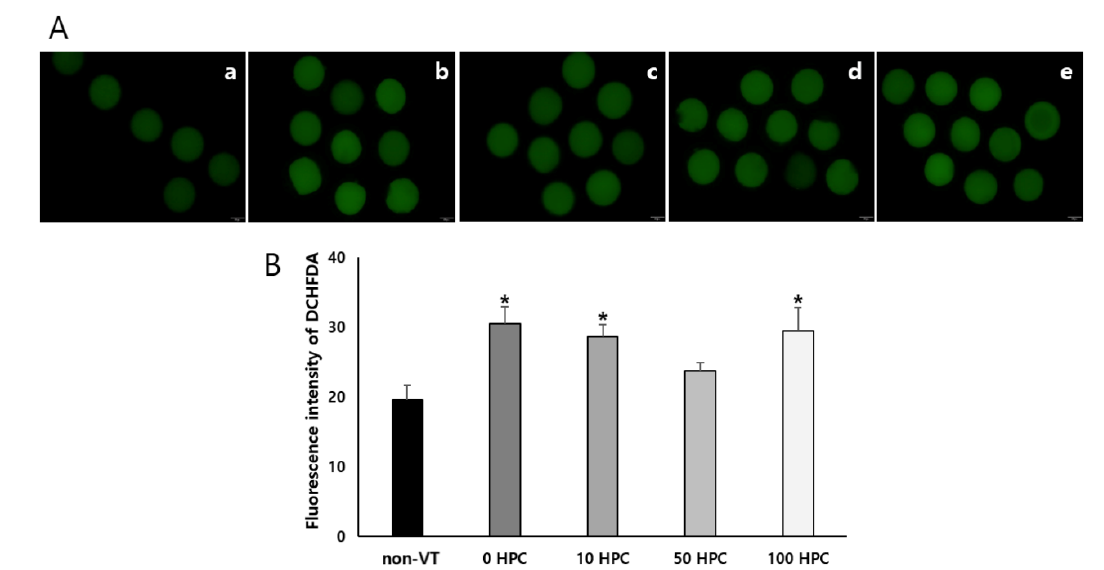
Figure 2. Comparison of levels of ROS in HPC (0, 10, 50, and 100) groups and the non-VT group. Fluorescence images of ROS ( A , a – e ). ROS activity was detected with DCHFDA (green). Fluorescence intensity of DCHFDA ( B ). * p < 0.05 compared with the non-VT group.